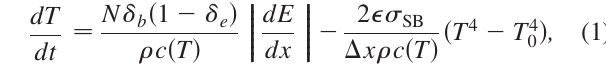
rf cavities in the recycler work with two harmonic voltages of 400 kVand (cid:1) 200 kV . Since the ratio of linac vs recycler rfs is not an integer, 325 = 52 : 8 ¼ 6 : 15 , the fractional part, 0.15, results in a slipping of linac microbunches along the rf